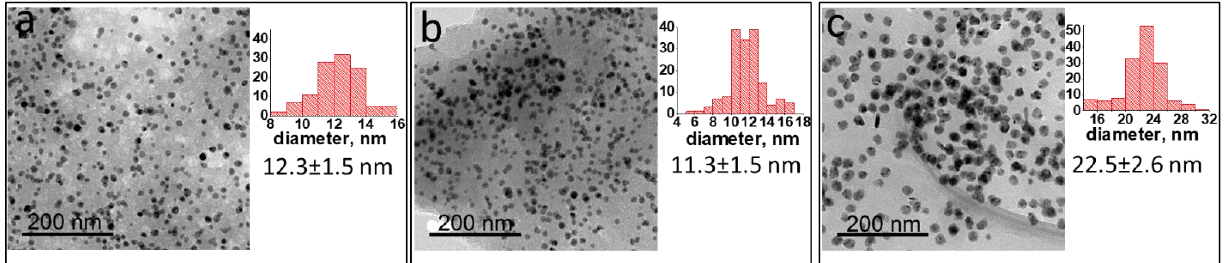
Figure 1. TEM images and size distributions of Ni NPs@PPP prepared by the heat-up approach at Ni(acac) 2 /PPP ratio = 1 mmol/0.148 g, for 30 min at 200 °C ( a ), 220 °C ( b ) and 280 °C ( c ).